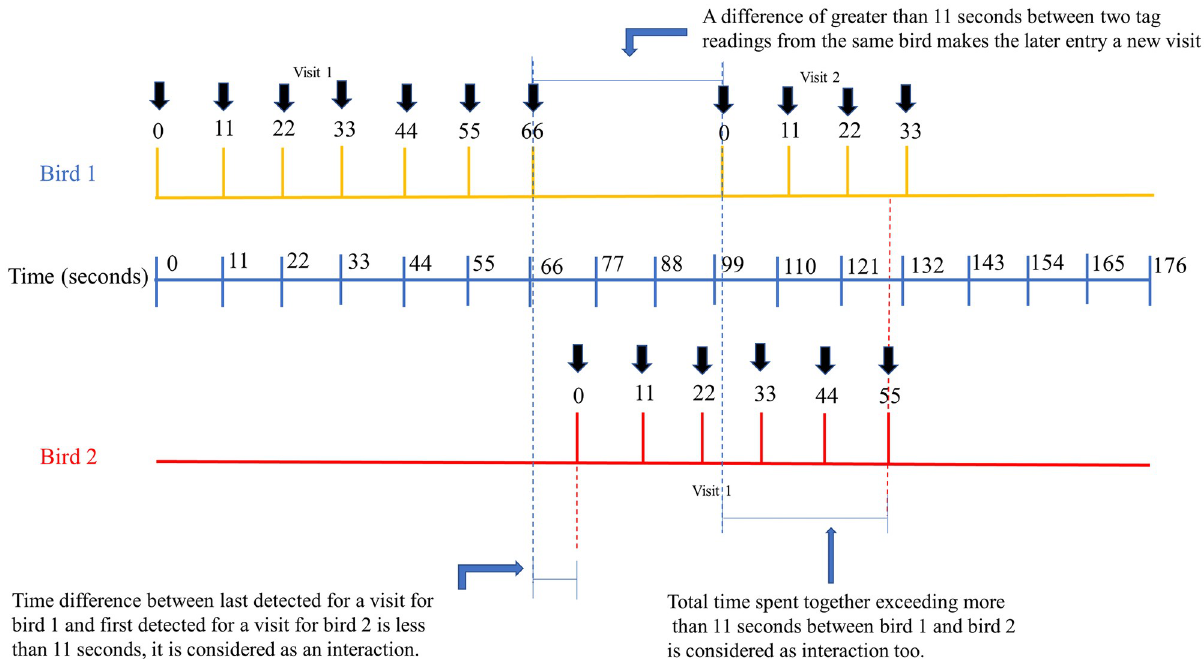
Fig 4. Figure showing passive integrated transponder tag detections of two hummingbirds on time axes and illustrating the estimation of visit duration and hummingbird interactions.